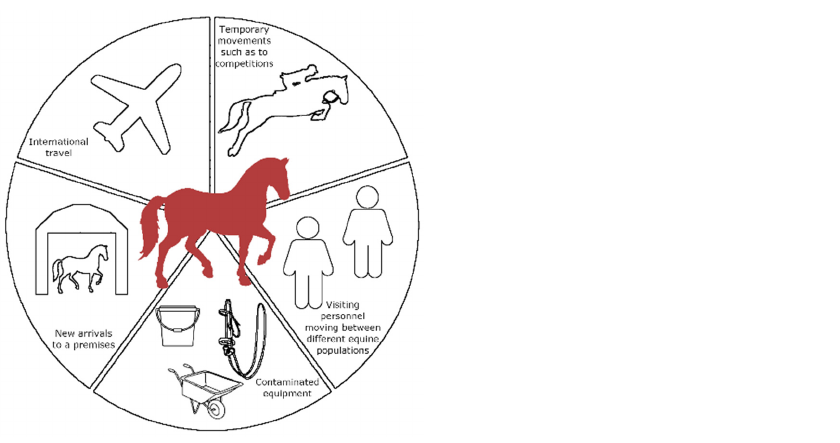
Figure 1. Common pathways for the introduction of an equine influenza virus infected horse to a population.